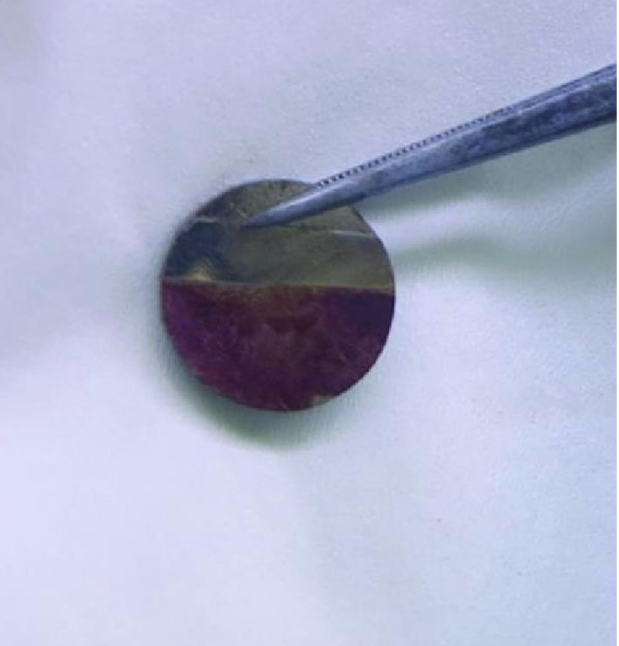
Figure 12. Photograph of a burgundy film on the surface of uranium after anodization in a 1-ethyl-3- methylimidazolium chloride–AlCl 3 mixture (1:2 molar ratio) at 6 mA cm − 2 for 2 min (reprinted with permission from ref. [52]; Copyright 2018 the author(s), published by The Electrochemical Society).